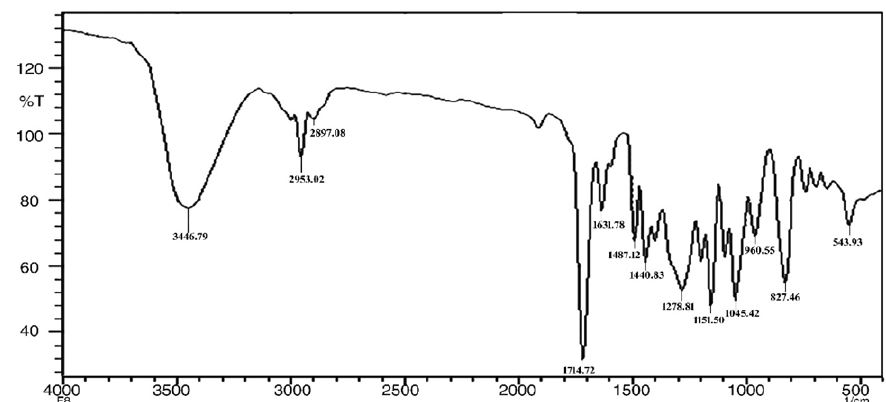
Fig. 2a . Experimental FTIR spectrum of Methyl 2-((4-chlorophenyl)(hydroxy)methyle) acrylate [MBHA (L1)]